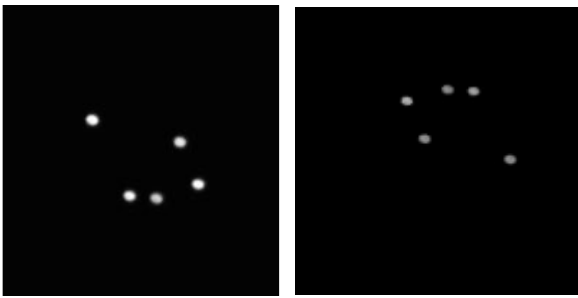
Figure 12. Left: Measuring image of a low-cost probe, Right: Measuring image of the toy drill probe with professional